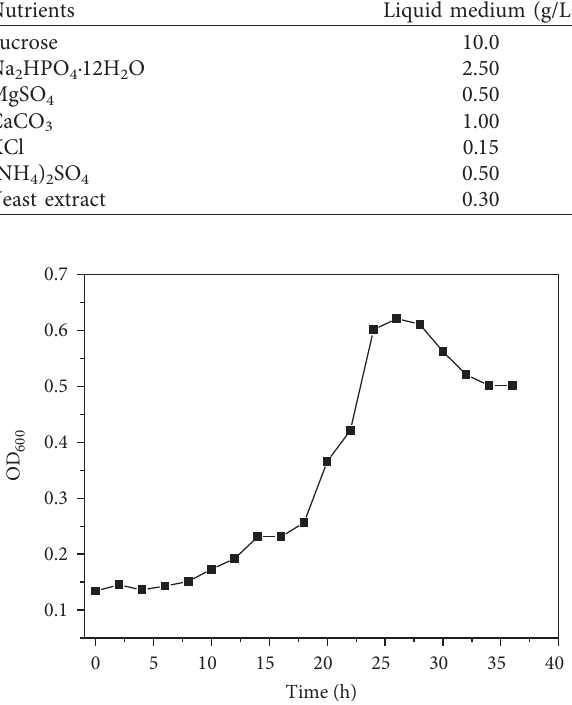
Figure 3: The growth curve of Paenibacillus (pH � 12).